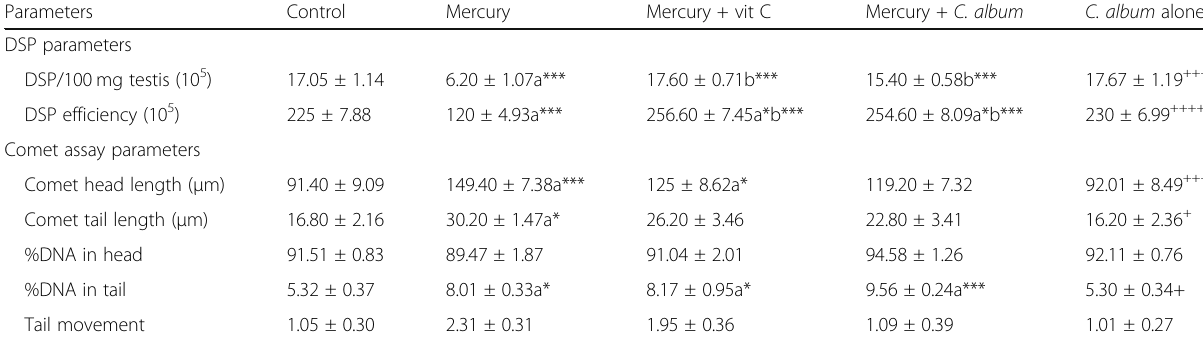
Table 4 Protective effect of C. album extract against HgCl 2 -induced alterations in DSP and DNA damage